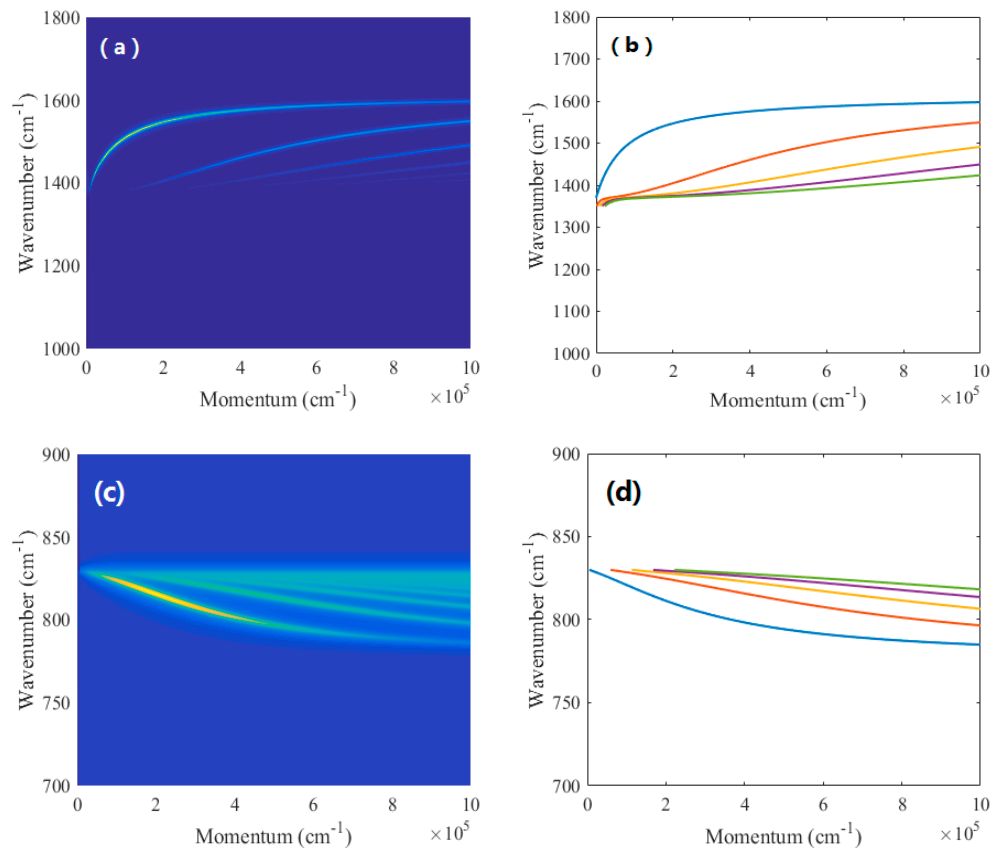
Figure 3. ( a , b ) Calculated transmission and dispersion of the freestanding h-BN slab near the type I band. ( c , d ) Calculated transmission and dispersion of the freestanding h-BN slab near the type II band.